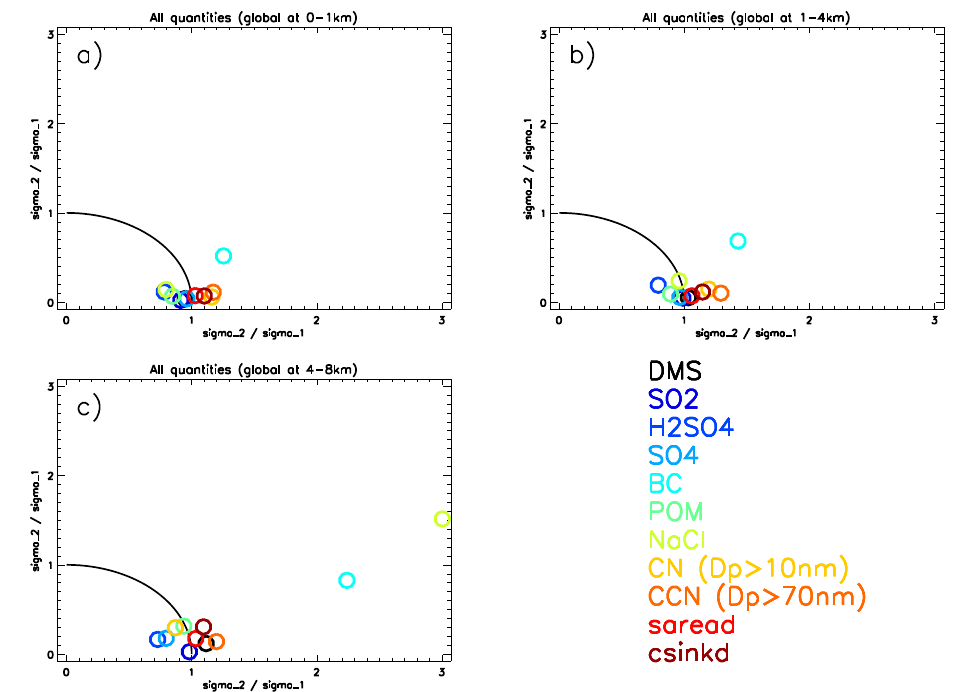
Fig. 12. Taylor diagrams showing how well GLOMAP-mode (v6R) compares against GLOMAP-bin for a range of metrics in different altitude ranges of (a) 0–1km, (b) 1–4km, (c) 4–8km. The distance to the perfect-model position indicating a measure of skill which combines the Pearson correlation coefficient and the relative variance for the two models